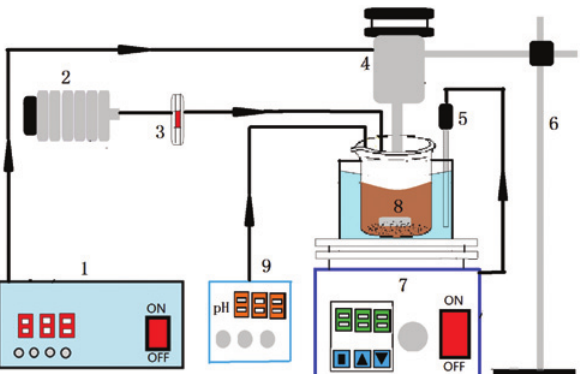
Figure 2: Schematic of experimental setup. (1) Ultrasound generator, (2) small-scale air compressor, (3) gas flowmeter,